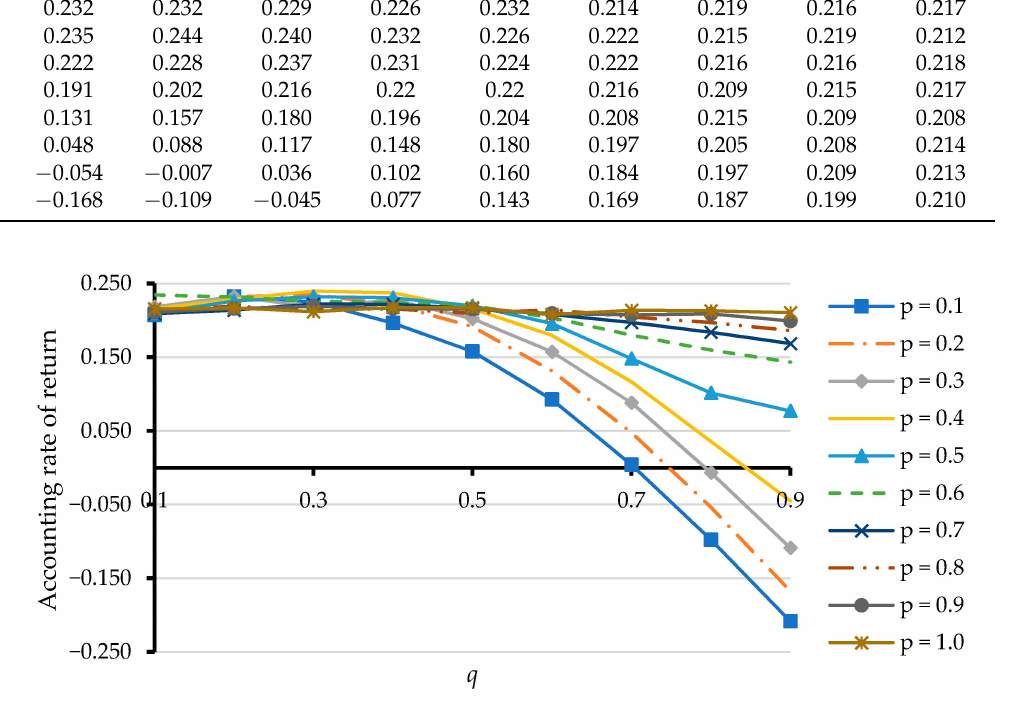
Figure 10. Accounting rate of return for different q and p . Graphic representation.